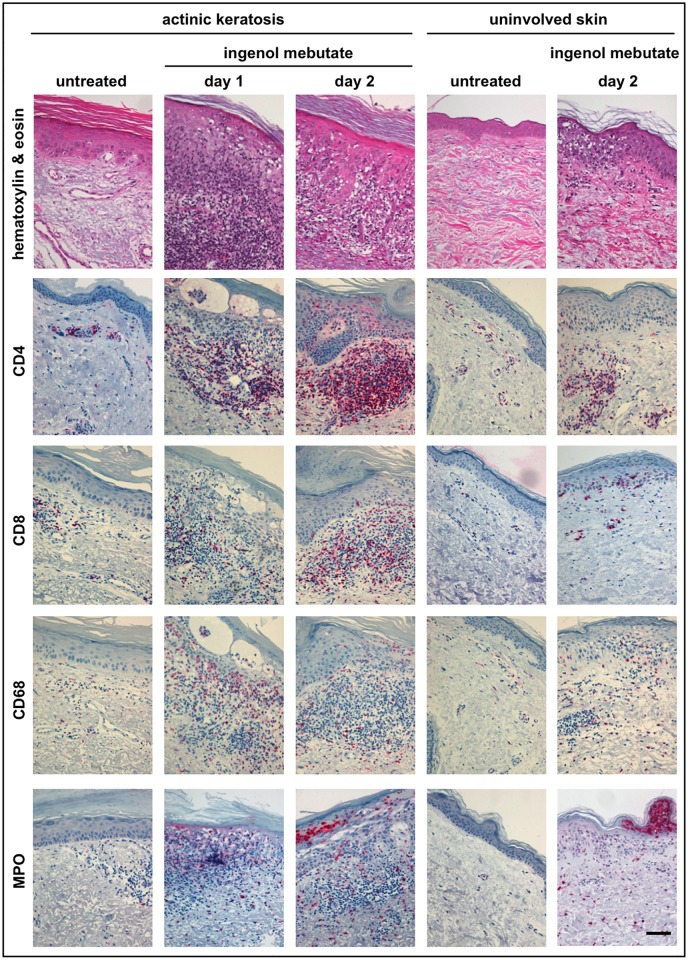
Ingenol mebutate 0.05% gel treatment causes rapid infiltration of T-cells, macrophages, and neutrophilic granulocytes.Biopsy specimens from all patients (n = 26) were subjected to histopathological evaluation. Skin tissues from the two treatment areas and all time points were assessed, and representative images are depicted. The panels depict hematoxylin & eosin staining as well as immunohistochemical staining for CD4+ T-lymphocytes, CD8+ T-lymphocytes, CD68+ macrophages/histiocytes, and myeloperoxidase (MPO+) neutrophils as indicated. The scale bar represents 100 μm.